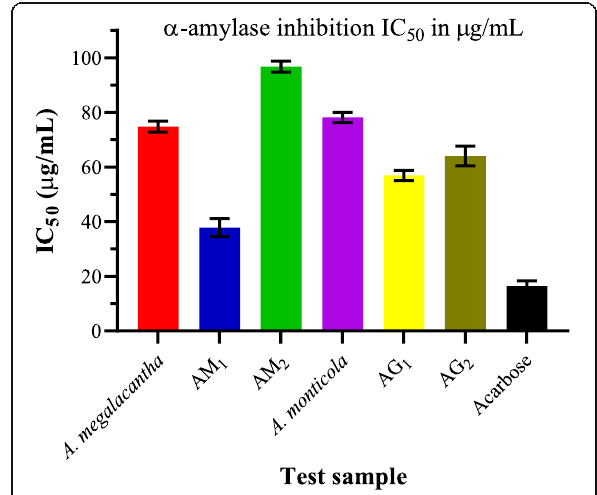
Fig. 3 IC 50 value of leaf latexes and TLC isolates of A. megalacantha and A. monticola